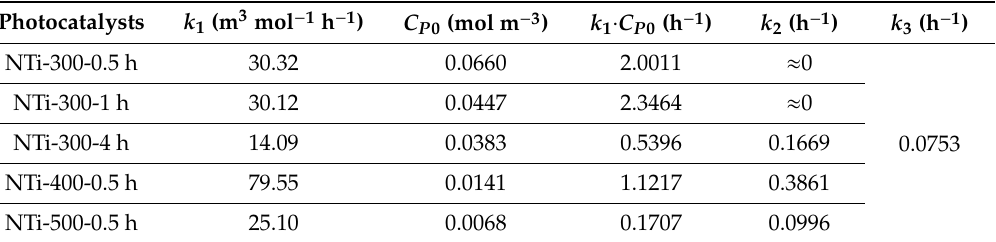
Table 2. The fitted parameters of the kinetics model k 1 , k 2 , k 3 , and C P 0 of N-TiO 2 .